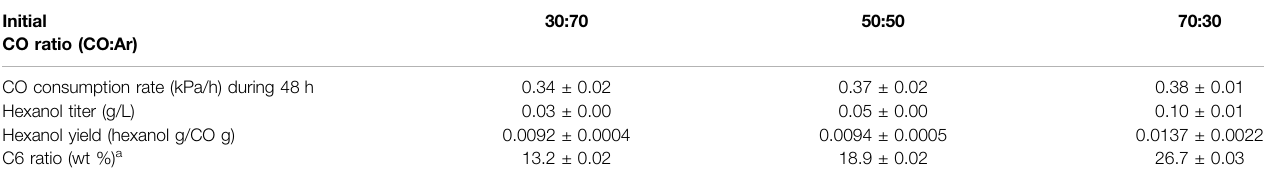
TABLE 1 | Effect of CO ratio on fermentation performance with the initial headspace pressure of 150 kPa. Initial CO ratio